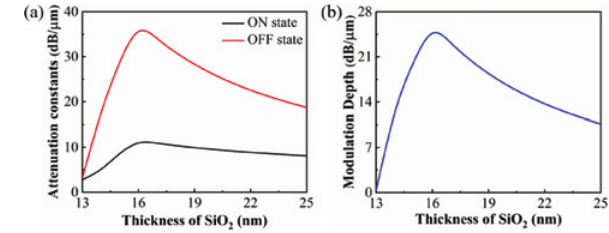
Figure 4: Imaginary part of n eff (a) at different t 1 and μ c , when w =100nmand λ =1550nm(b)atdifferent w and μ c ,when t 1 =20nm and λ = 1550 nm.